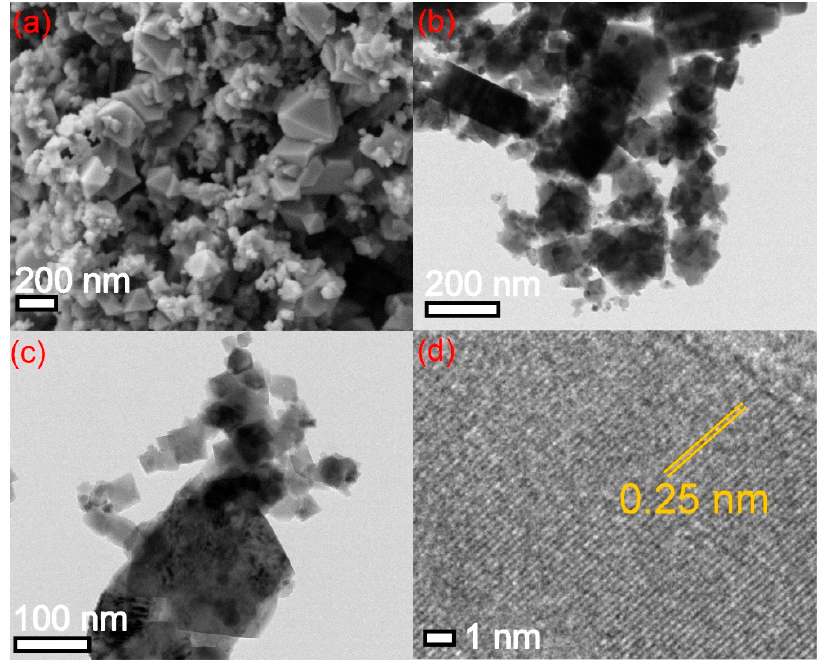
Figure 2. ( a ) SEM, ( b , c ) TEM, ( d ) HRTEM images of Cu 0.5 Mn 0.5 Fe 2 O 4